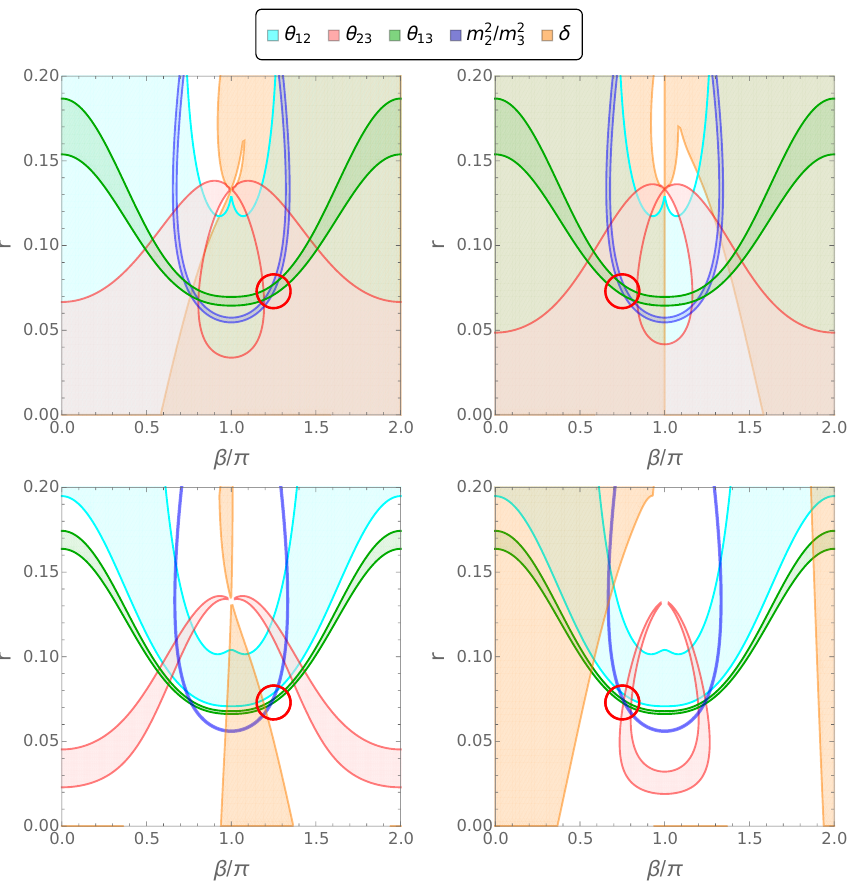
√ −√ 6 case ( left ) and for the n = 1 6